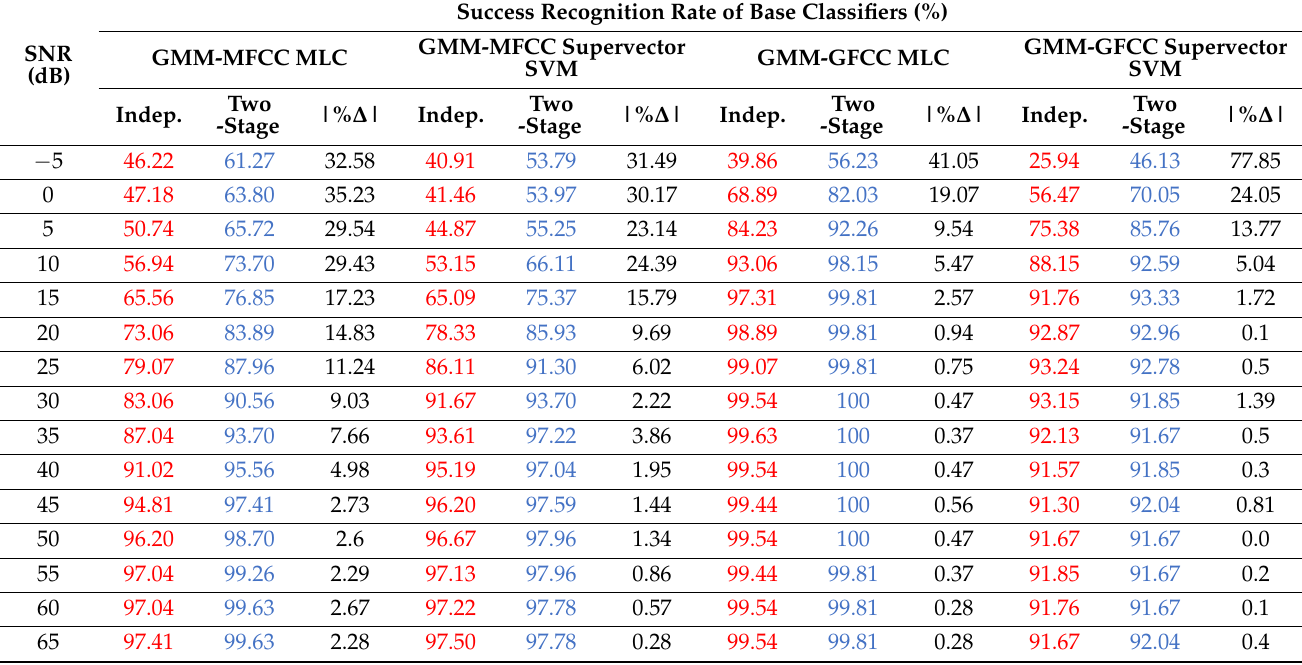
Table 2. Comparison of recognition rates for the base classifiers when they are used within the proposed system (blue) with that of the same base classifiers when they are used independently (red) on utterances distorted with pink noise.